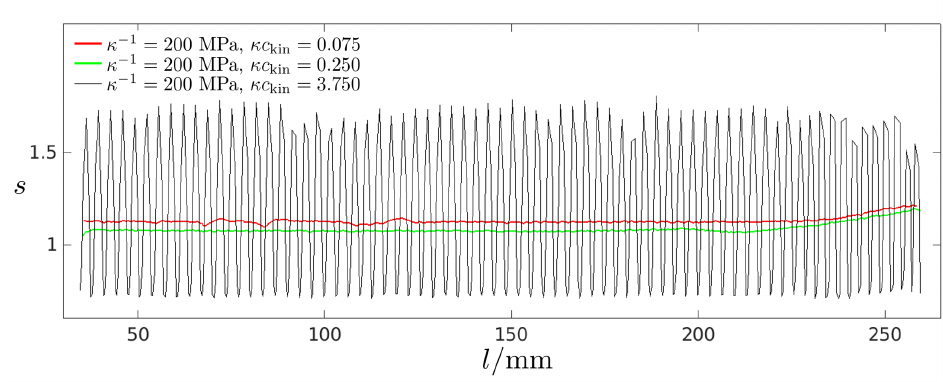
Figure 8. The effective plastic strain s (cf. Equation (9)) as a function of the position in the billet (cf. Figure 7). Undeformed areas and the unsteady flow at the beginning of the process are omitted.